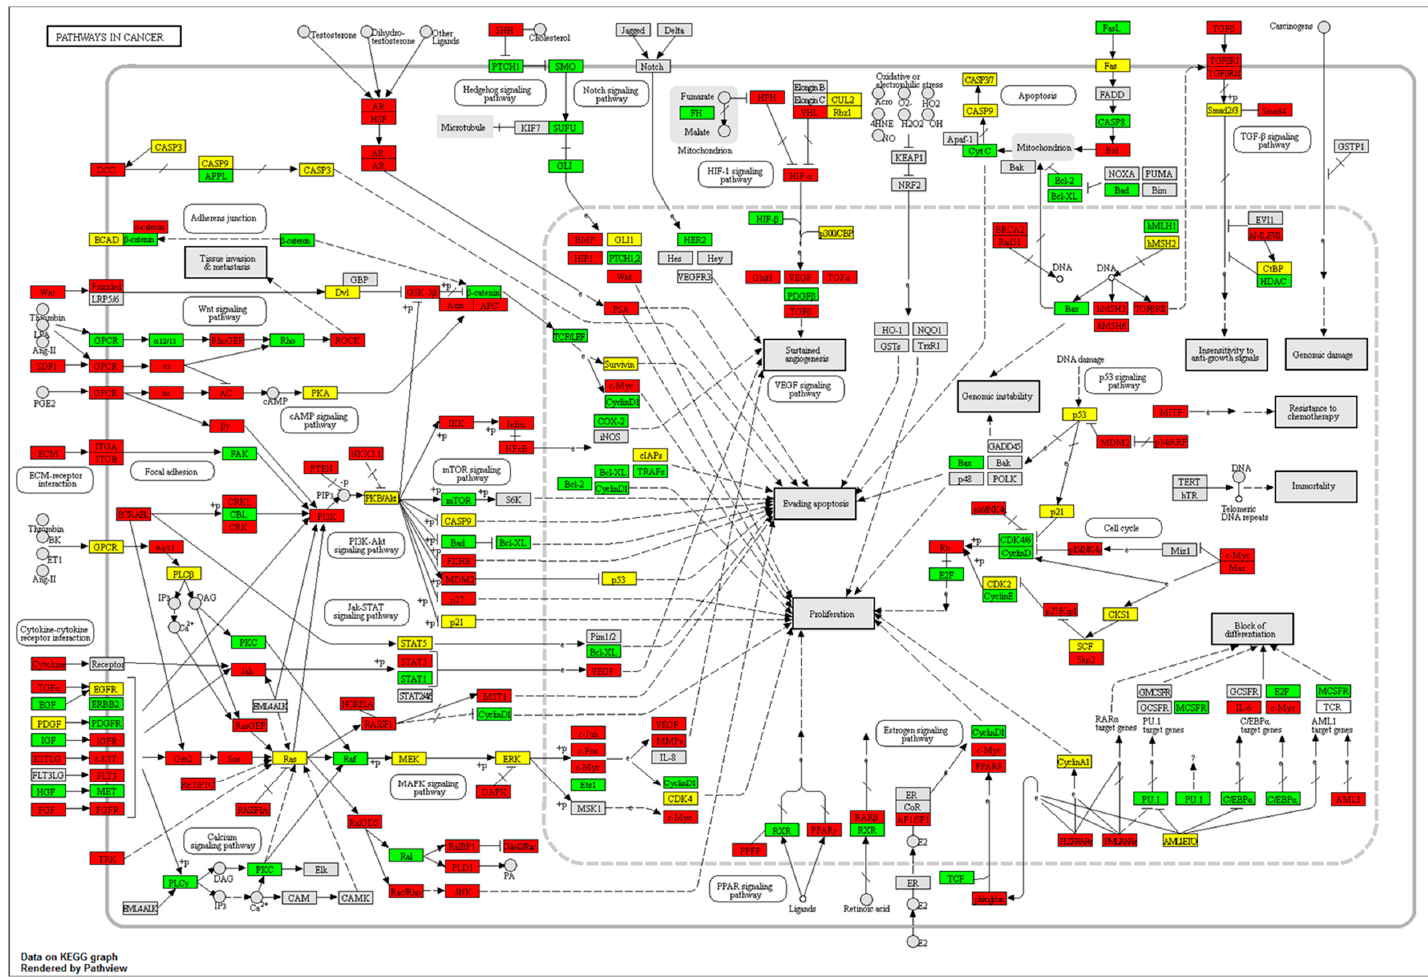
Figure 6. Use of the Kyoto Encyclopedia of Genes and Genomes (KEGG) database to display cancer pathway-associated genes affected by 188 Re-liposome mediated miRNA expression in HPC. Red: Up-regulated genes; green: down-regulated genes; yellow: unknown regulated genes; gray: unchanged genes.